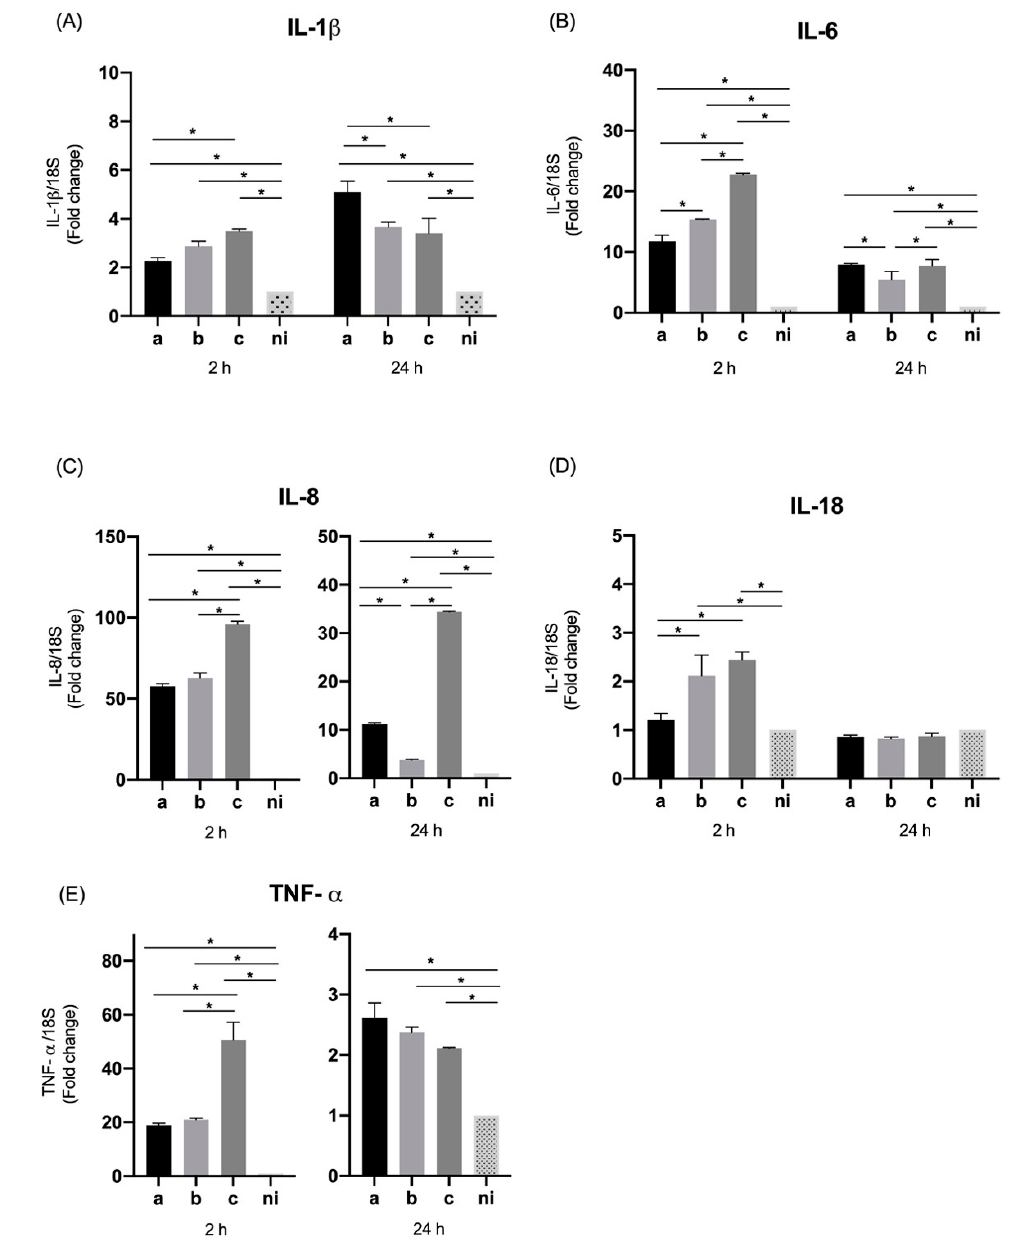
Figure 1. Cytokines and chemokines mRNA expression by Aggregatibacter actinomycetemcomitans -induced oral epithelial cells (OKF6/TERT2). Expression in oral epithelial cells infected at a MOI = 10 2 with strains ATCC ® 43717 TM (serotype a), ATCC ® 43718 TM (serotype b), and ATCC ® 43719 TM (serotype c), 2 and 24 h after infection. For relative expression, mRNA expression in non-infected (ni) oral epithelial cells was considered as 1, as a reference for fold-change in expression using 18S rRNA expression levels as a normalizing endogenous control. Data are represented as fold-change means and standard deviation of three independent experiments performed in duplicate. ( A ) IL-1 β , ( B ) IL-6, ( C ) IL-8, ( D ) IL-18, and ( E ) TNF- α . Asterisks were used to indicate a value of p considered statistically significant (* p <